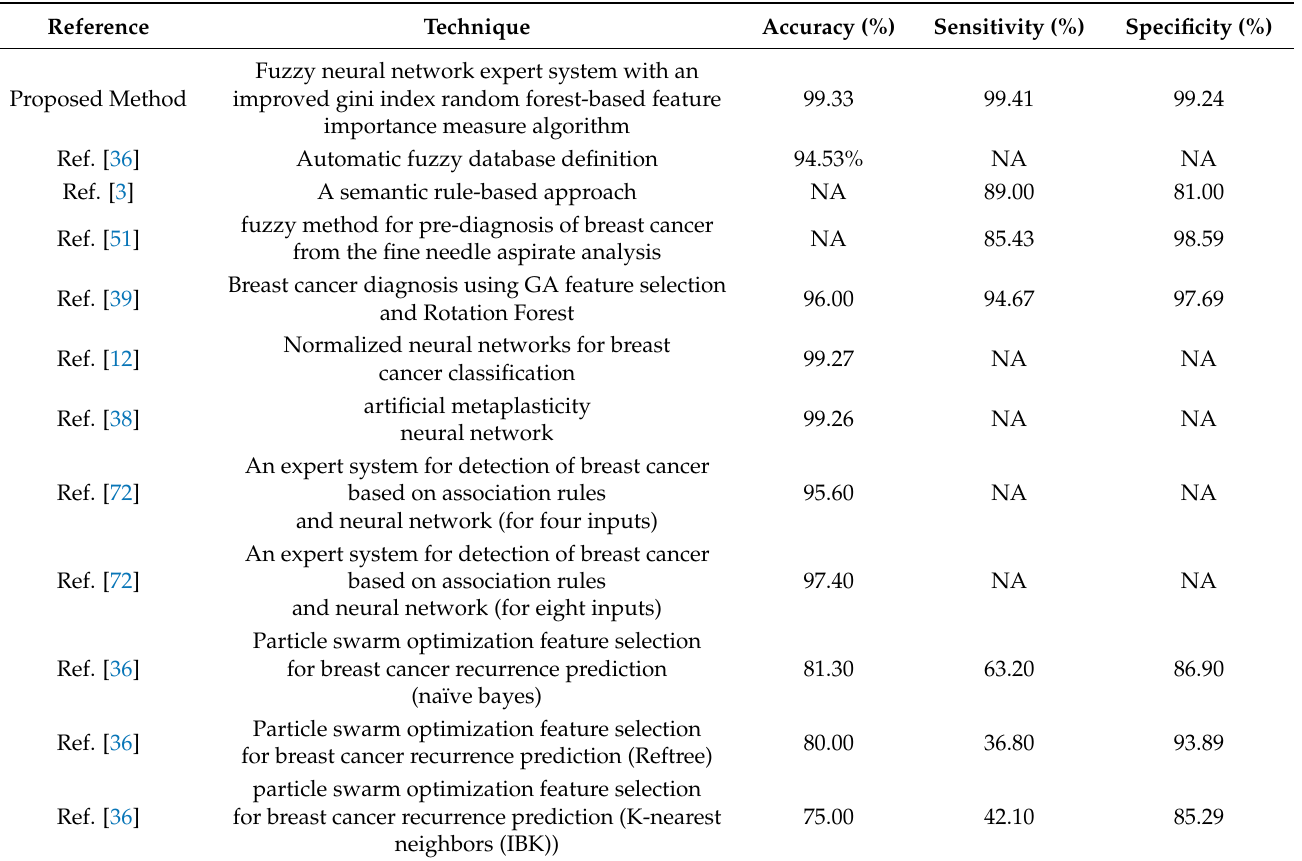
Table 8. Comparison between the proposed method and existing works using WBCD